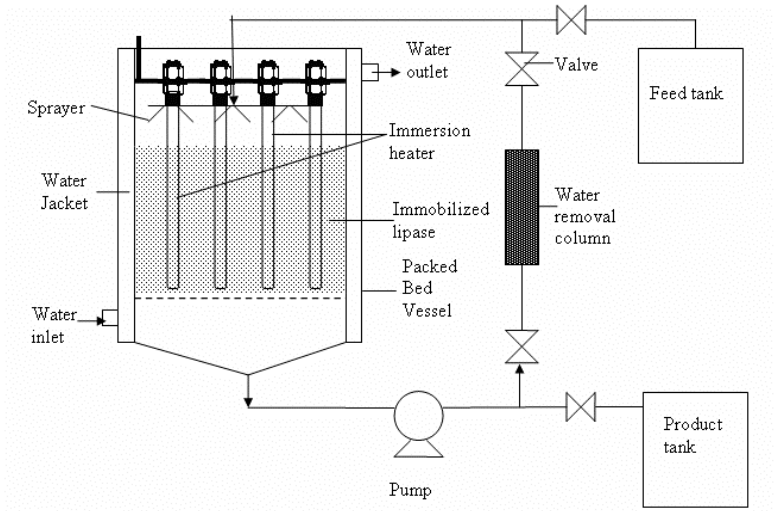
FIGURE 1. Schematic diagram of the setup of PBR use for the esterification process.